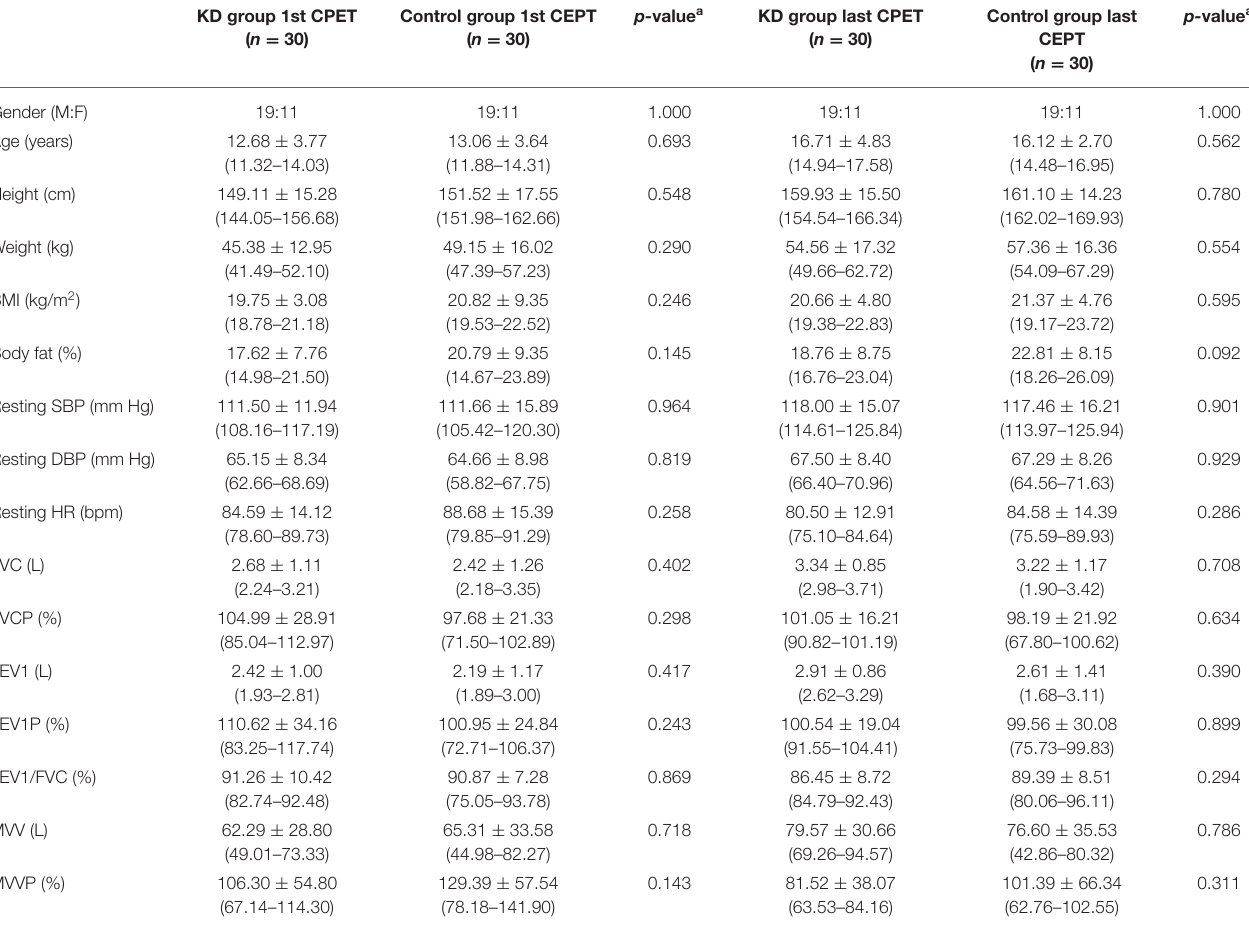
TABLE 1 | Demographic characteristics of patients with Kawasaki disease and